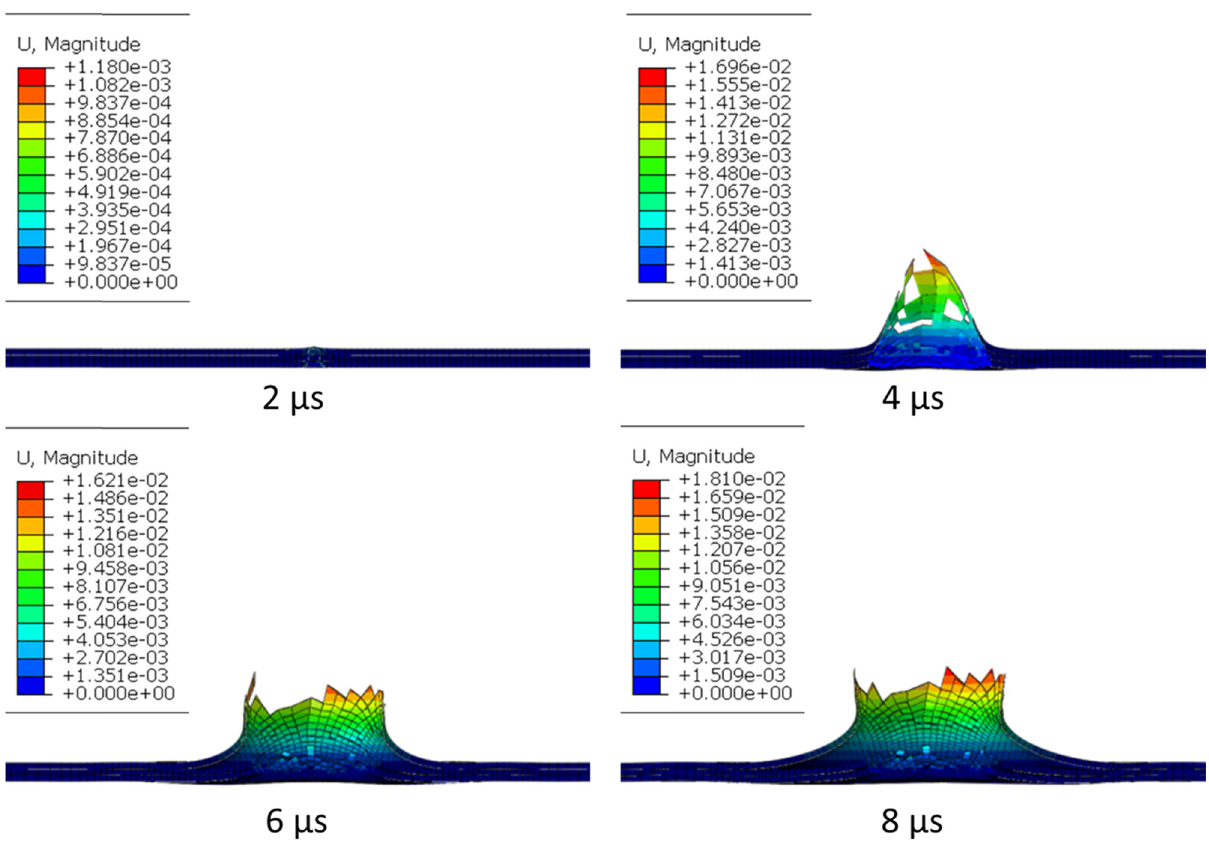
Figure 21: Displacement for model 7 against conical